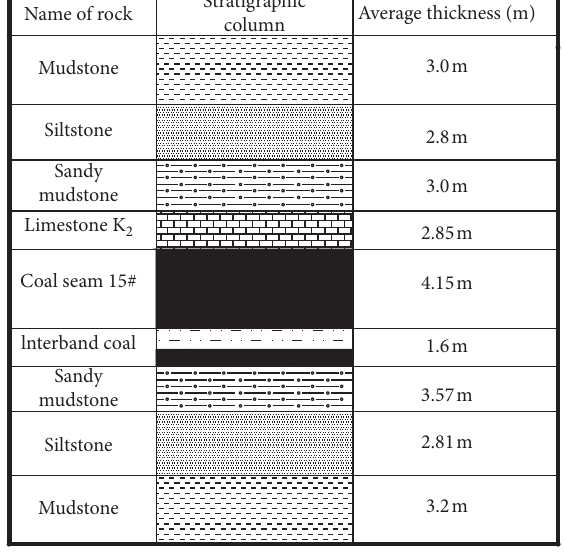
Figure 17: The bar graph of lithology of roadway surrounding